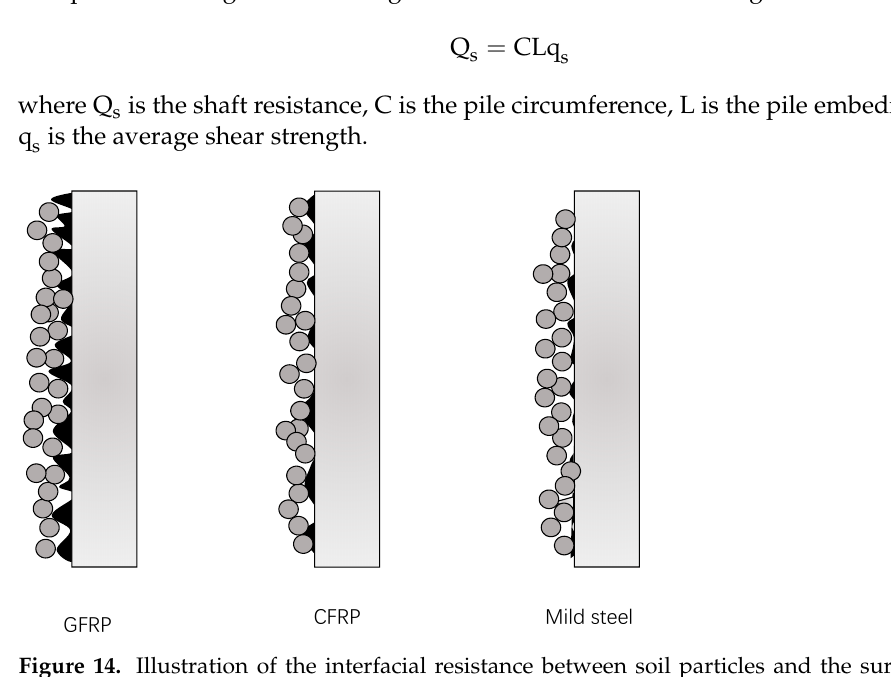
Figure 13. Surface roughness (R t ), confined pressure ( σ c ), and relative density (D r ) affecting the be ‐ haviour of FRP piles under an axial load. The shaft resistance can be estimated using Equation (2) [33], which is also affected by the interfacial resistance between the soil particles and the surface roughness of the FRP pile (Figure 14). When the surface roughness coefficient is larger, q s will be larger. A larger q s will obtain a larger shearing resistance in the shaft (Q s ). Additionally, this shaft resistance is also in the vertical direction, so Q s will resist the load in the axial direction. Therefore, an FRP pile with a larger surface roughness coefficient will resist a larger axial load.